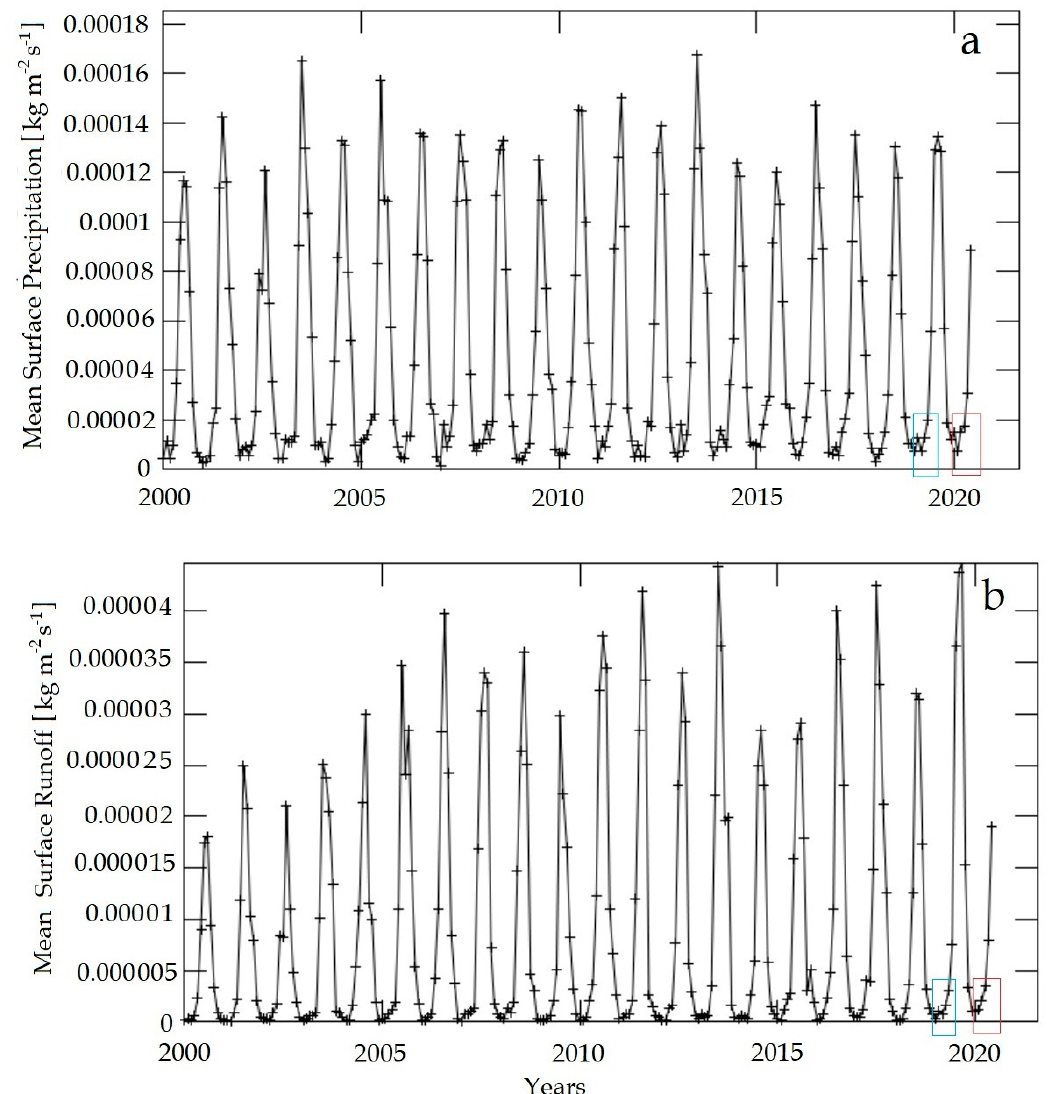
Figure 4. ( a ) Time-series of area averaged monthly mean surface precipitation from January 2000 to June 2020; ( b ) Time-series of area averaged monthly mean surface runoff from January 2000 to June 2020 for India. Blue and red boxes indicate the pre-monsoon months (January-April) of 2019 and 2020 respectively. Surface precipitation (MERRA-2 Model M2TMNXFLX v5.12.4) and overland runoff, including through-flow (MERRA-2 Model M2TMNXLND v5.12.4), were derived from NASA’s MERRA-2 long-term global re-analysis model.